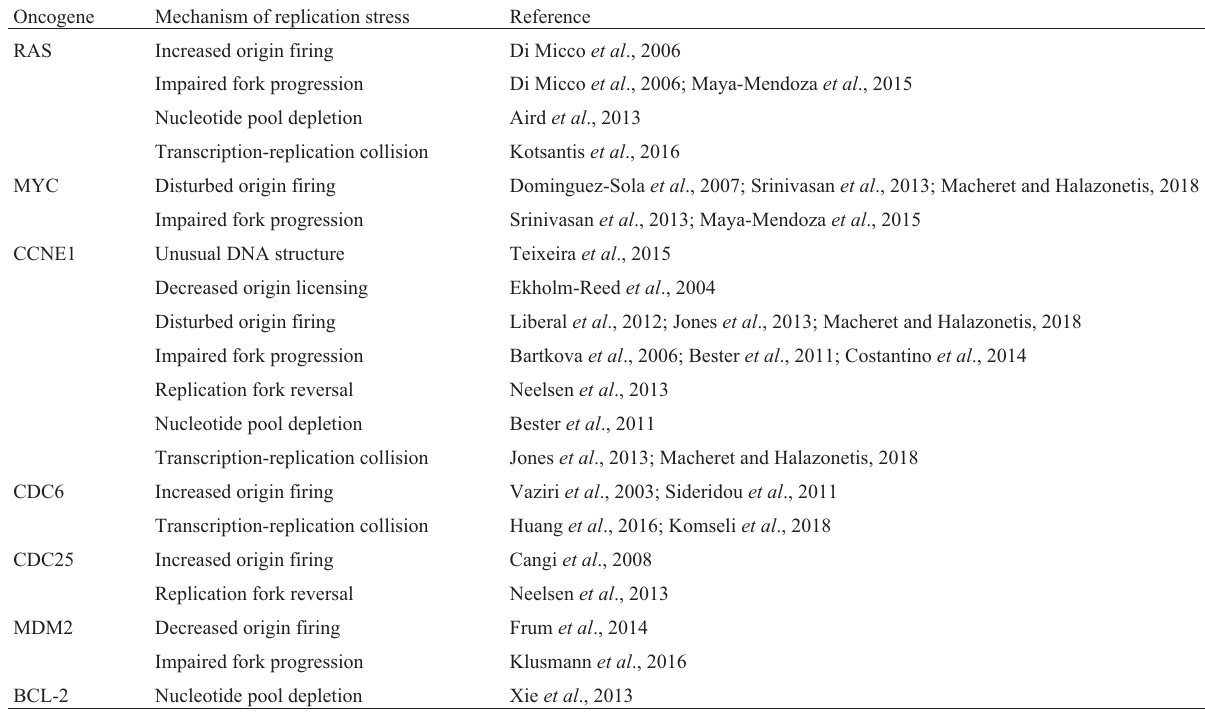
Table 1 - Mechanisms of DNA replication stress induced by different oncogenes.